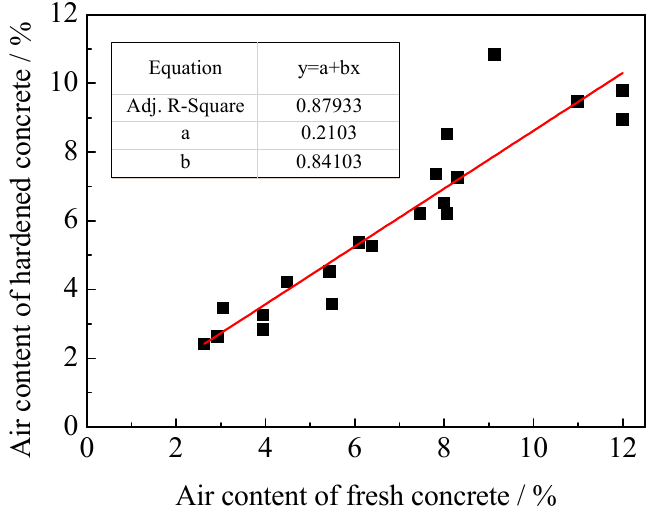
Figure 5. The relationship between the air contents of fresh and hardened concrete.